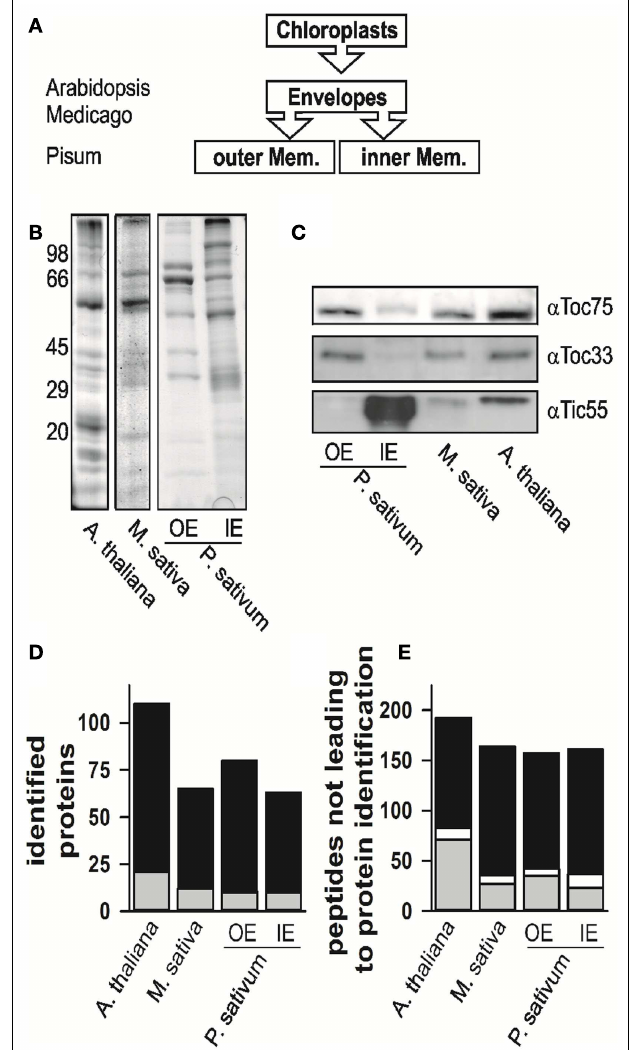
FIGURE 1 |The proteome analysis. (A) Schematic representation of which fractions were isolated and analyzed.The different species are indicated for the envelope fraction results of six independent replicates, three after trypsin and three after elastase digestion were combined. (B) The fractions of mixed envelope of A. thaliana and M. sativa as well as the outer (OE) and inner envelope (IE) membrane of P. sativum were subjected to SDS-PAGE analysis followed by Coomassie Blue staining.The migration of the molecular weight standard is indicated on the left. (C) The purity of the fractions in (B) was assessed byWestern blotting using indicated antibodies. (D) Numbers of proteins identified in the according fractions by MALDI nano-LC-MS/MS and the two digestion methods indicated. Gray indicates the portion for which more than one AGI was assigned for one protein family, in white the portion where more than one isoform was specifically identified for one protein, black indicates the portion for which one AGI was assigned. (E) Numbers of peptides not assigned by MALDI nano-LC-MS/MS and BLAST assignment. Gray indicates the portion of peptides, which were assigned to one amino acid sequence only, whereas white indicates the portion of peptides, which were assigned to various proteins, black indicates the portion of peptides, which were not assigned at